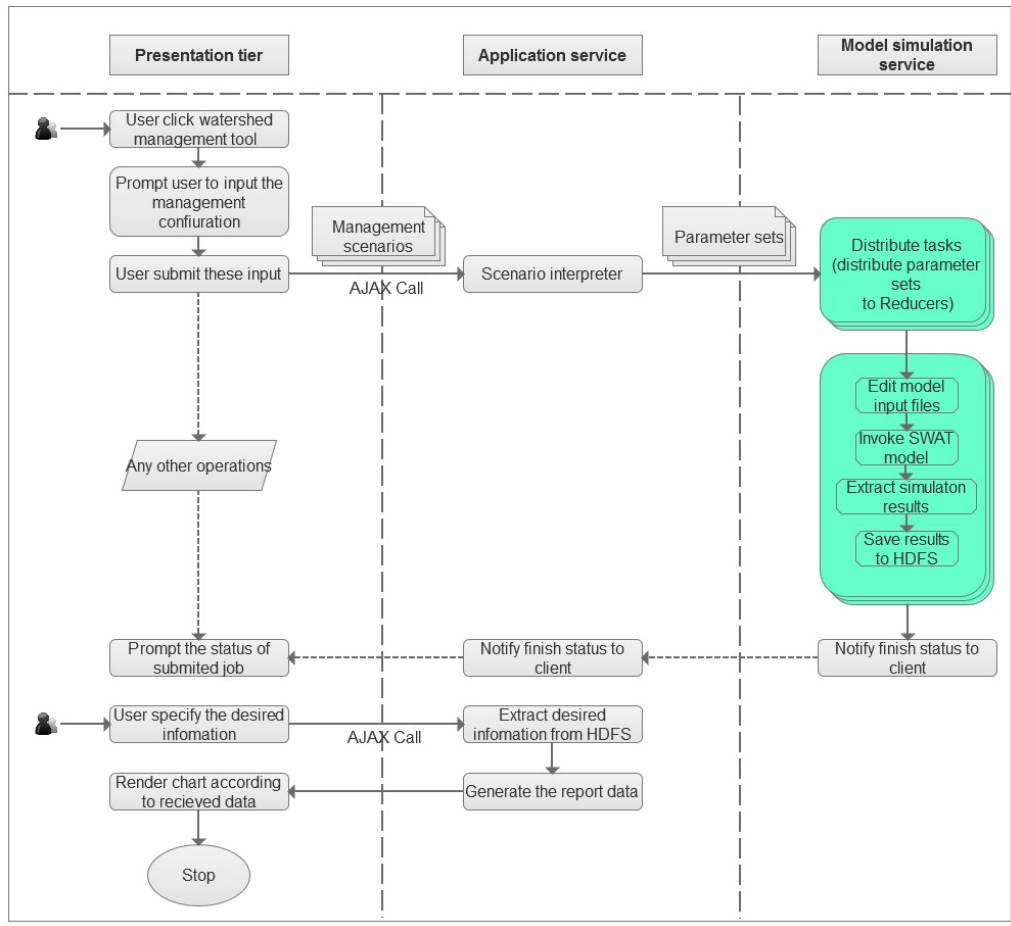
Figure 2. Parallelizing the simulation of management scenarios (the colored parts are the execution in parallelizing). AJAX, Asynchronous JavaScript and XML; HDFS, Hadoop Distributed File System; SWAT, Soil and Water Assessment